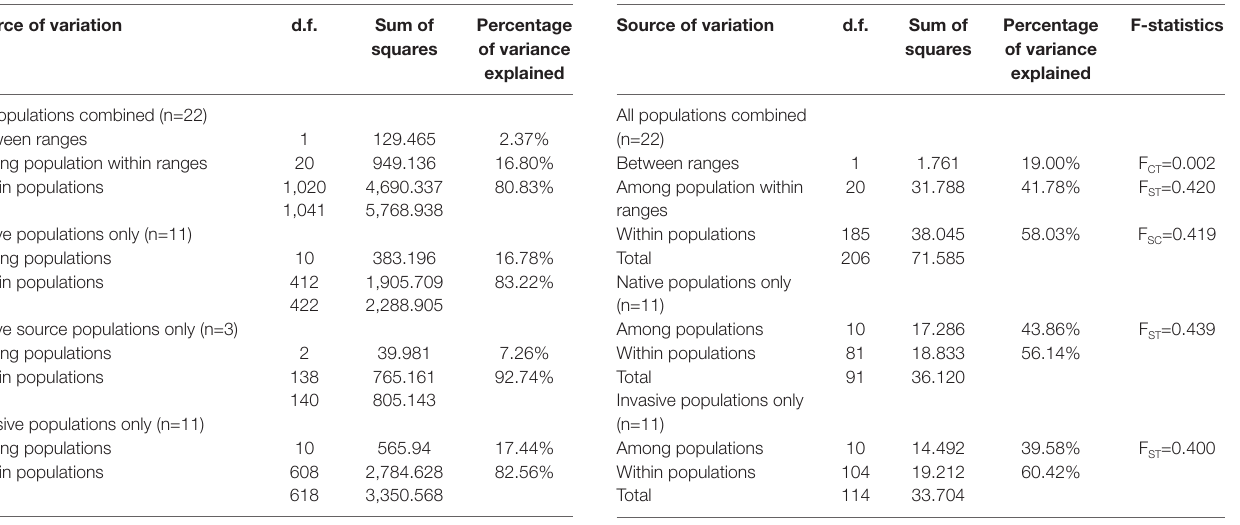
TaBle 3 | Analysis of molecular variance for populations of S. alterniflora based on chloroplast dataset